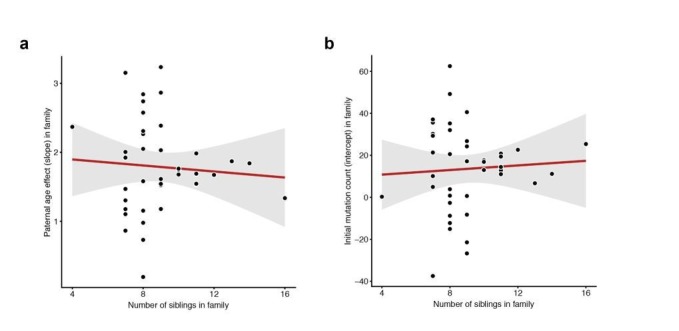
Lack of correlation between sibling number and either slope or intercept.For each CEPH/Utah family, we fit a linear model predicting DNM counts as a function of paternal age (see Figure 3). We then assessed whether the number of third-generation siblings in these families was predictive of either the (a) slope or (b) intercept point estimate in the regression. Neither slope (p = 0.654) or intercept (p = 0.718) are significantly associated with sibling number.